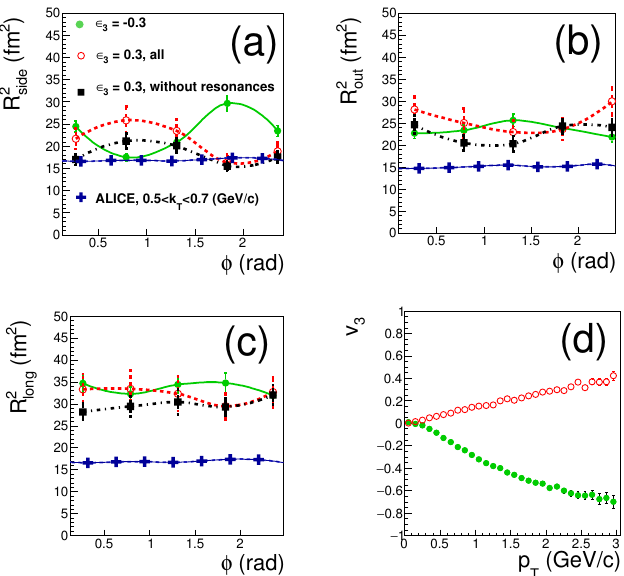
( ∆ φ ) , R 2 ( ∆ φ ) , and R 2 ( ∆ φ ) , respectively, 3 3 3 out side long √ s = 2.76 GeV with the centrality 20–30%. The k T